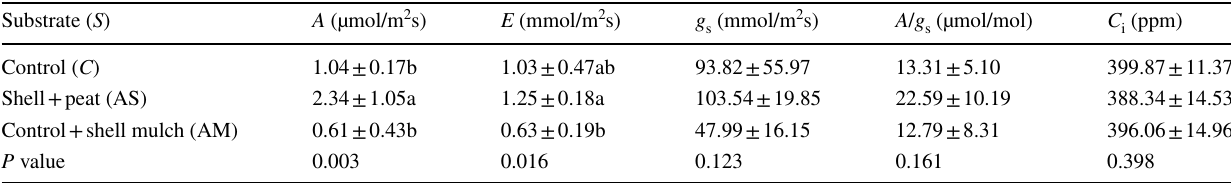
Table 3 Influence of the substrate on green bean plants leaf gas exchange parameters 60 days after sowing